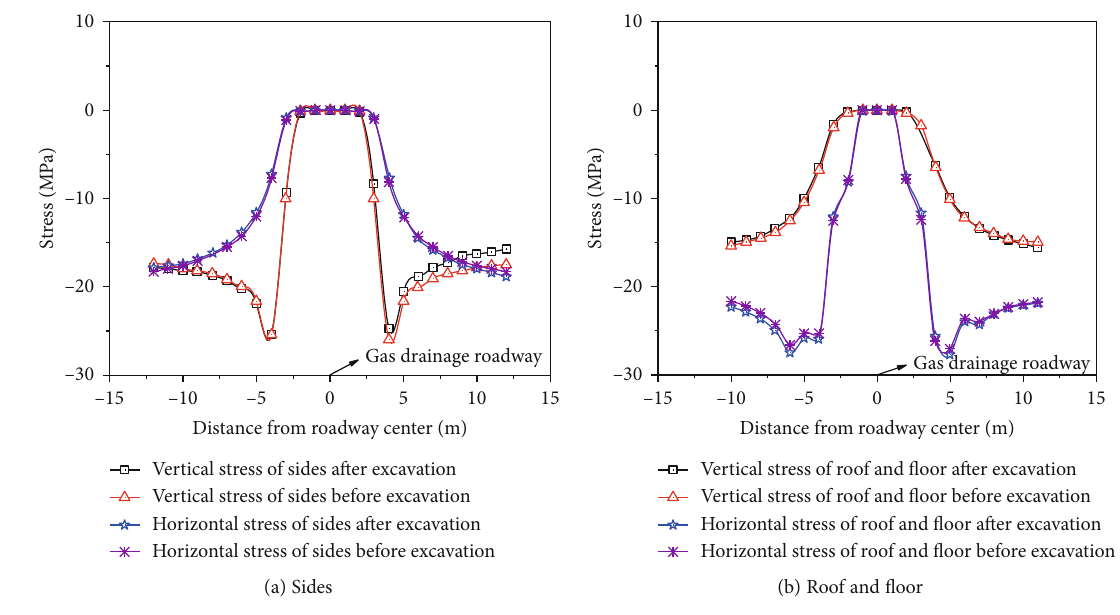
Figure 12: Stress distribution curve of roadway surrounding rock after